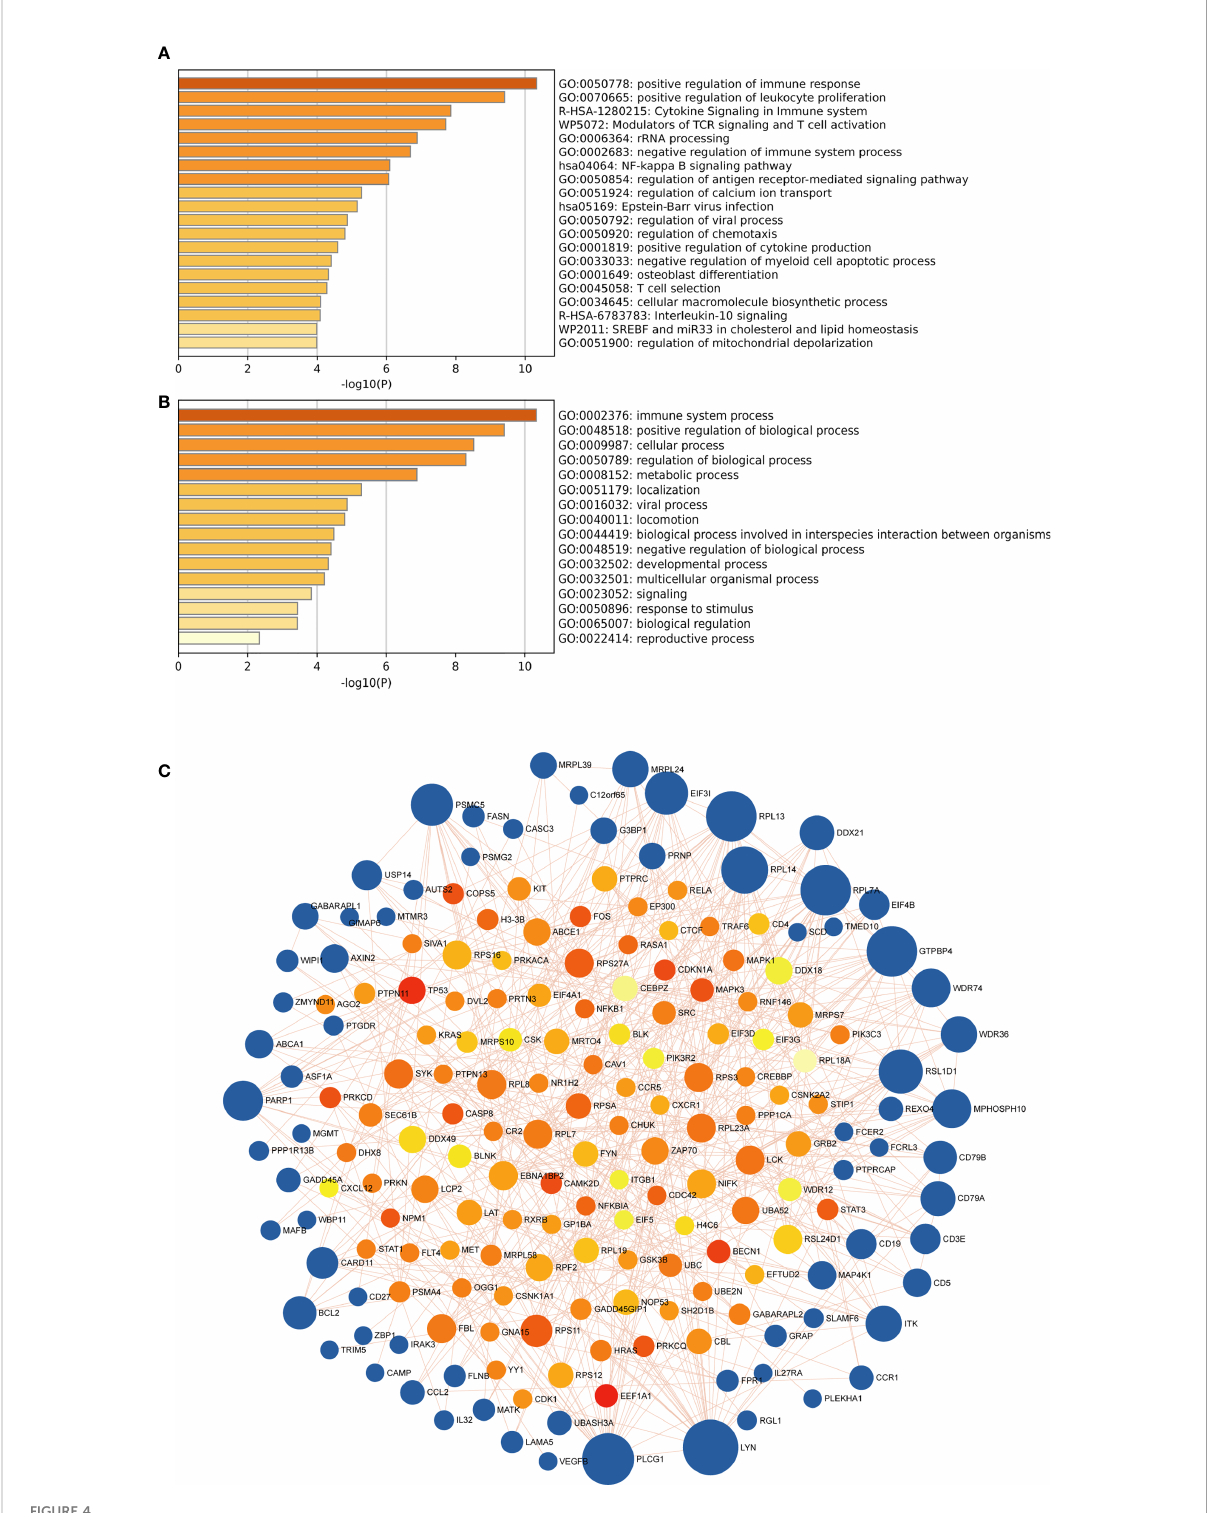
FIGURE 4 (A) the top 20 enriched clusters across feature genes, colored by p-values. (B) The top-level Gene Ontology biological processes colored by p- values. The darker the color, the stronger the enrichment of the gene in that pathway. (C) The PPI network of feature genes. Each blue node represents a gene, and each other node represents a protein. Different sizes indicate the core degree of genes in the PPI network, whereas a bigger size indicates more importance in the